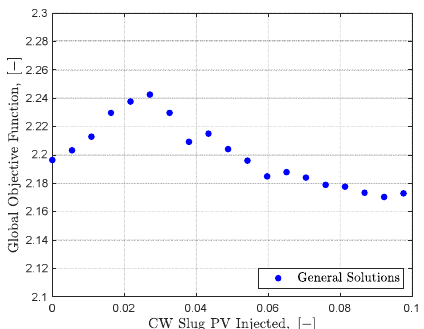
Figure 12. Objective function value as a function of carbonated water slug volume injected.